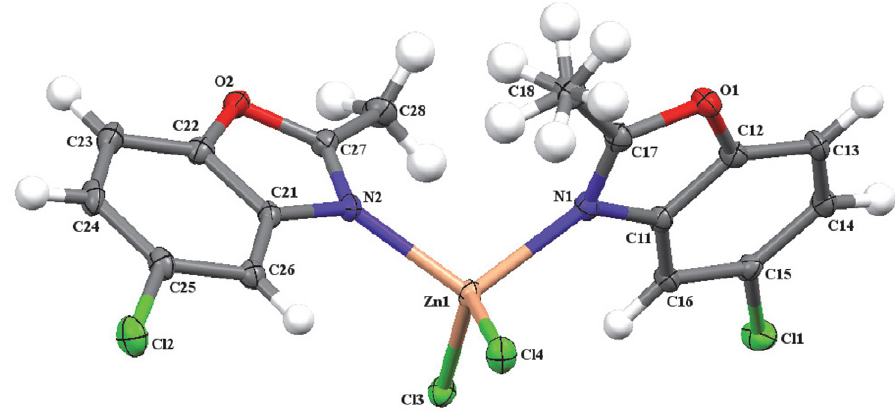
Figure 1. Single-crystal x-ray molecular structure of the complex. ellipsoids with a 30% of probability